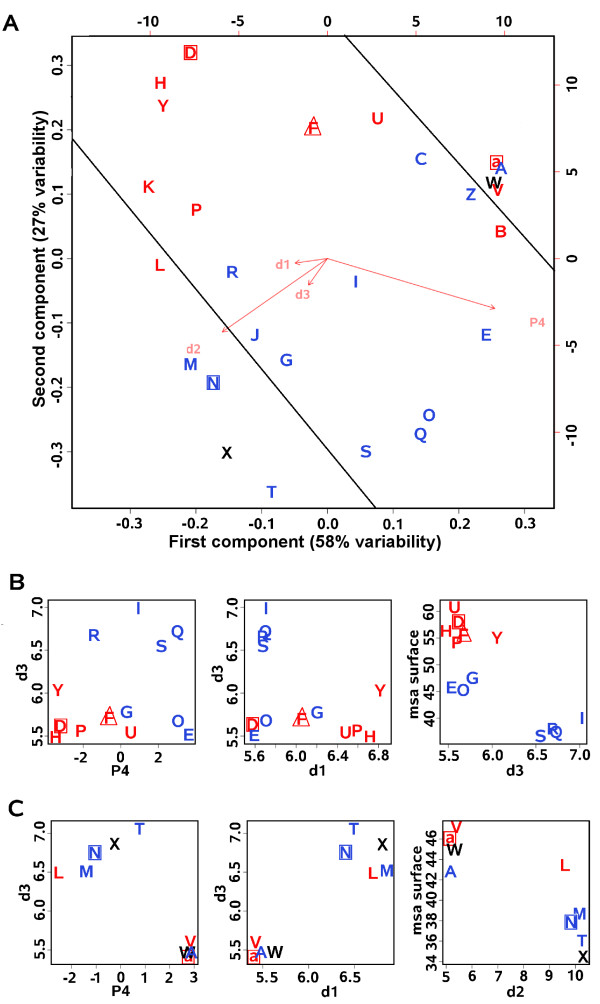
Structural characteristics of the structural letters. Structural descriptors analysis of surface-letters (red), core-letters (blue), non-interface-letters (square), interface-letter (triangle) and non characterized ones (black). A) Principal Component Analysis performed on the structural descriptors d1, d2, d3 and P4 of the 27 structural letters. The first component is associated with 58% of variability, the second one to 29% of variability and the third and fourth axis to 7% and 6% respectively. Plain lines separate letters according to their secondary structural types. B) Correlation plot d3/P4, d3/d1 and msa/d3 for loop-letters. Msa (Mean solvent accessibility) are computed for the surface compartment but similar observations are made for the interface compartment. C) Correlation plots d3/P4, d3/d1 and msa/d2 for α- and β-letters. Msa stands for the mean relative solvent accessibilities, it is calculated for each letter in the surface compartment of the complete dataset.